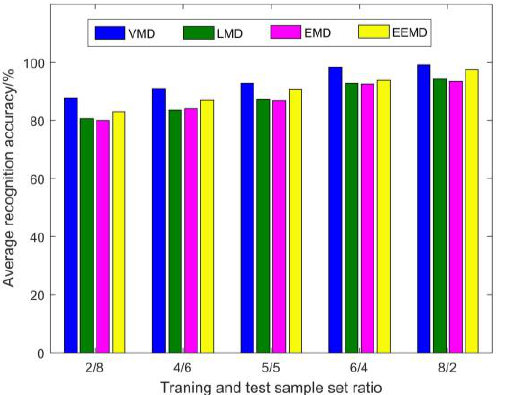
Figure 17. Average recognition precision of different training and test sample set ratios.